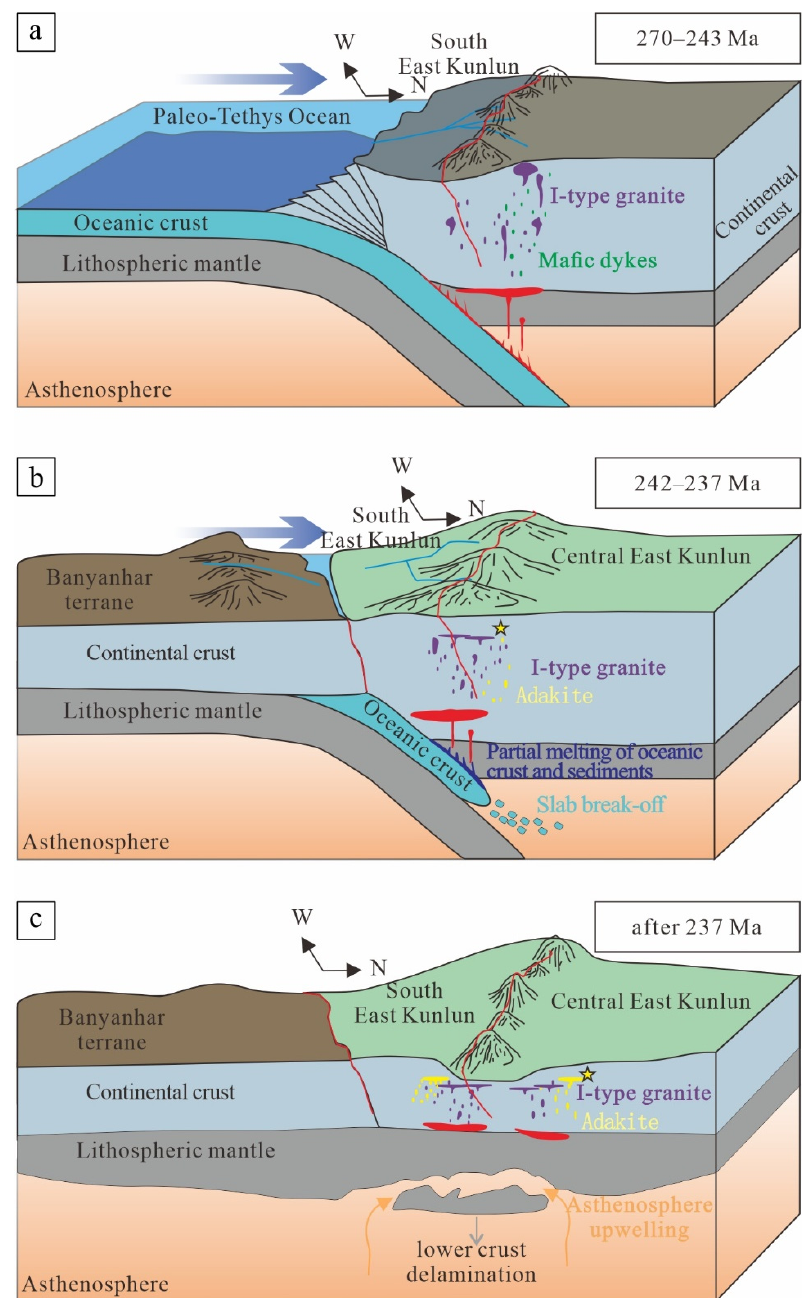
Figure 10. Geological evolution in the EKOB. The Paleo-Tethys Ocean subduction between 270 and 243 Ma ( a ); the syn-collision stage is between 242 and 237 Ma ( b ); the post-collision extension setting stage is after 237 Ma ( c ).